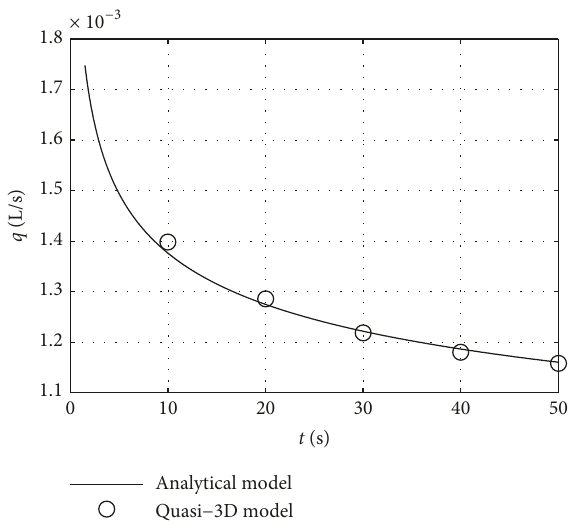
Figure 13: Variations of the diffusion radius with time in Case 2.